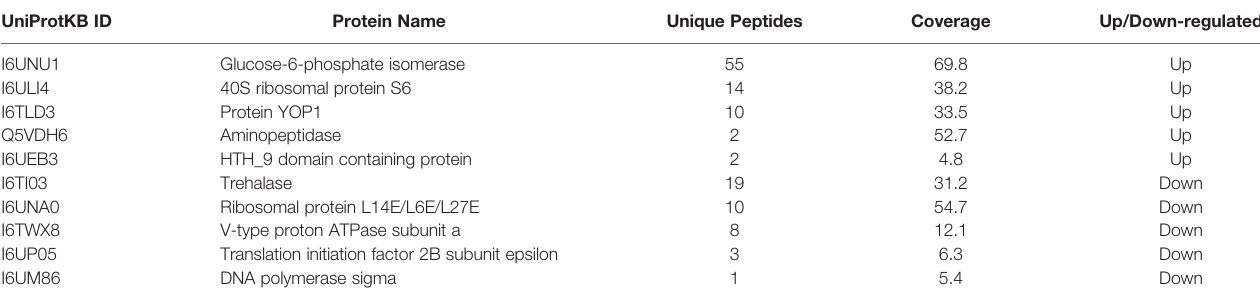
TABLE 1 | Representatives of ddifferentially expressed proteins of E. hellem after VWF incubation. UniProtKB ID Protein Name Unique Peptides Coverage